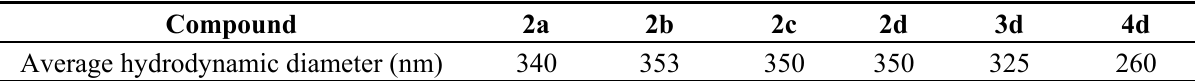
Table 2. Hydrodynamic diameter of the different para -acylcalix[4]arenes based SLN prepared in phosphate buffer saline (PBS) measured by photon correlation spectroscopy (PCS). Compound